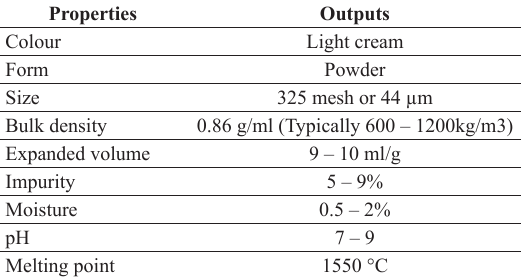
Table 2. Typical characteristics of sepiolite 8